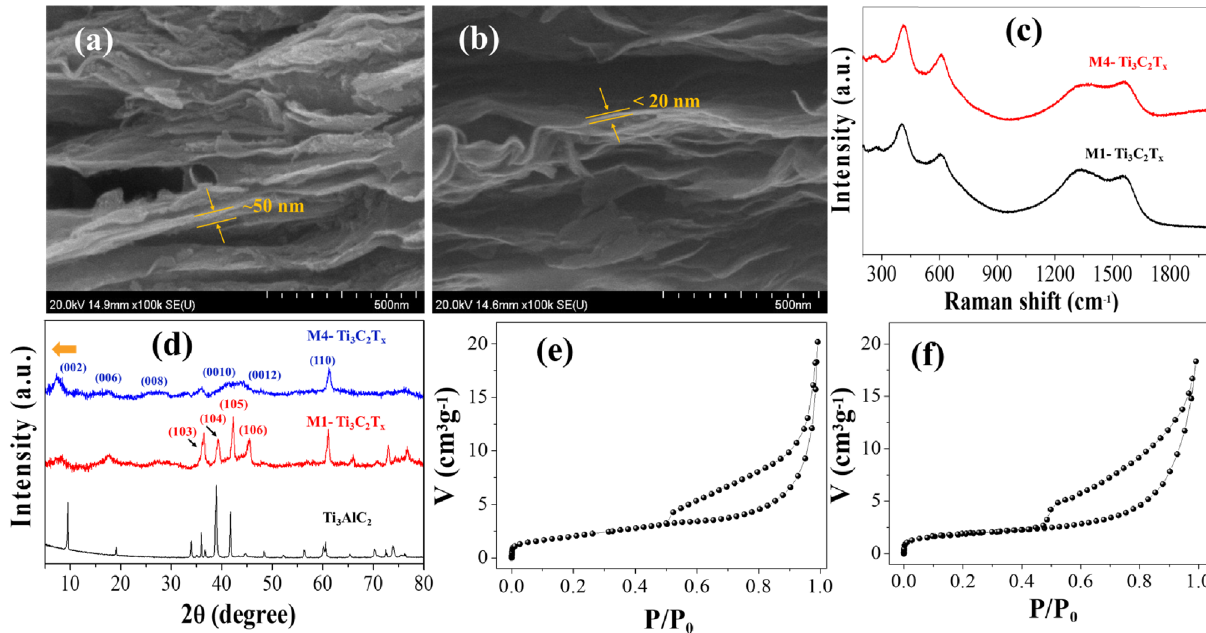
Figure 2. ( a , b ) FESEM images of M1 and M4 MXenes. ( c ) Raman spectra show characteristic peaks of